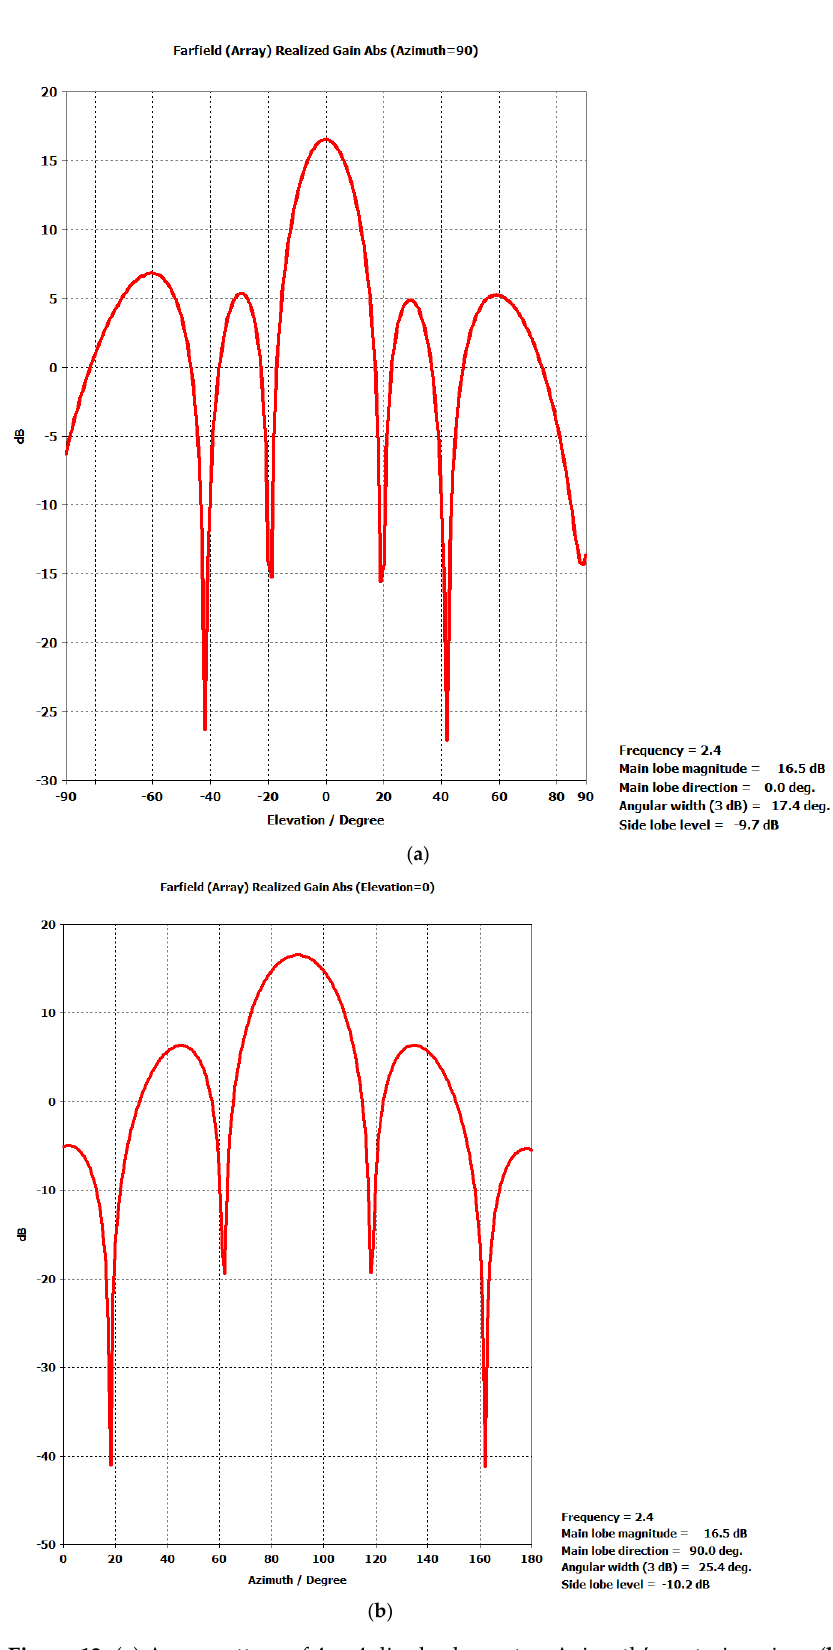
Figure 13. ( a ) Array pattern of 4 × 4 dipole elements—Azimuth’s cartesian view; ( b ) Array pattern of 4 × 4 dipole elements—Elevation’s cartesian view. Calculating the gain of the 4 × 4 dipole array according to the approximation in Equa- tion (8) for the omni-directional array, we get: